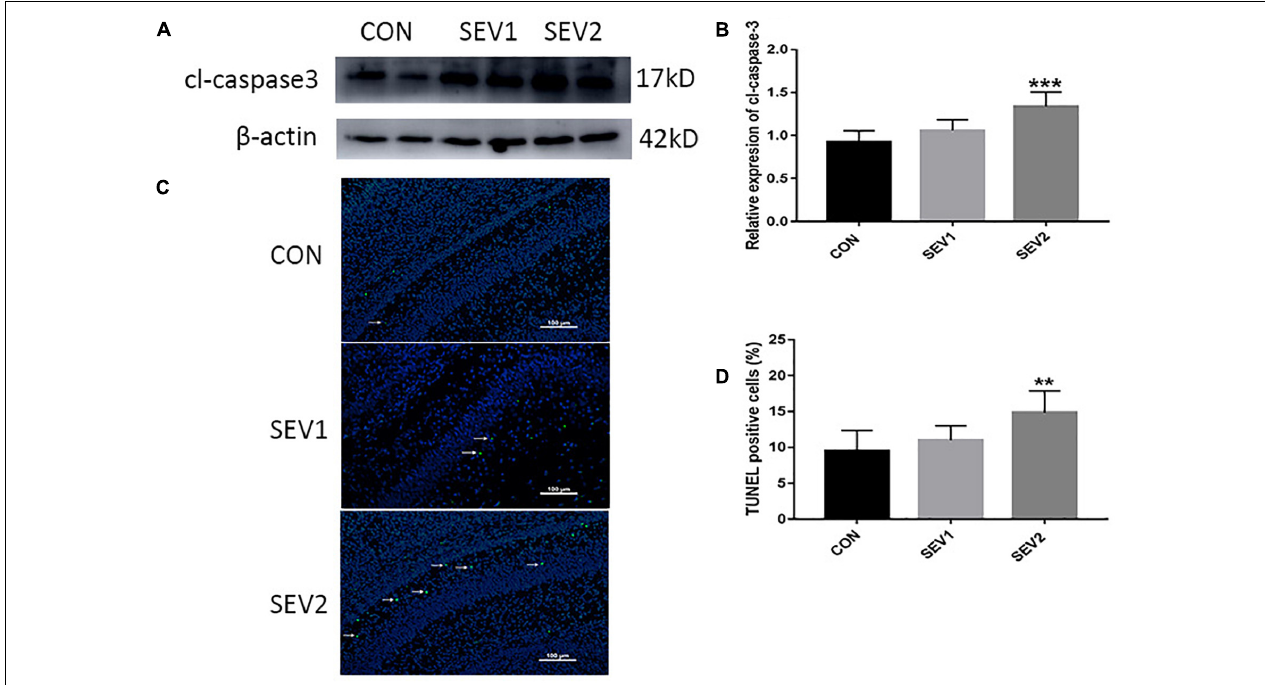
FIGURE 1 | Pregnant rats exposed to 3% sevoflurane for 4 h led to increased neuroapoptosis in offspring hippocampus. G20 rats exposed to 3% sevoflurane exhibited significantly increased cl-caspase3 expression via Western blot analysis (A) and TUNEL-positive cells (green) (C) in the P1 rat hippocampus. Quantification of cl-caspase3 normalized to β -actin (B) . Quantification of TUNEL-positive cells (D) . Data are expressed as mean ± SEM ( n = 6 in each group). Comparisons were made using one-way ANOVA and post hoc Tukey’s correction. ∗∗ P < 0.01, ∗∗∗ P < 0.001, compared to the CON group. Images are 200 × . Scale bar = 100 µ